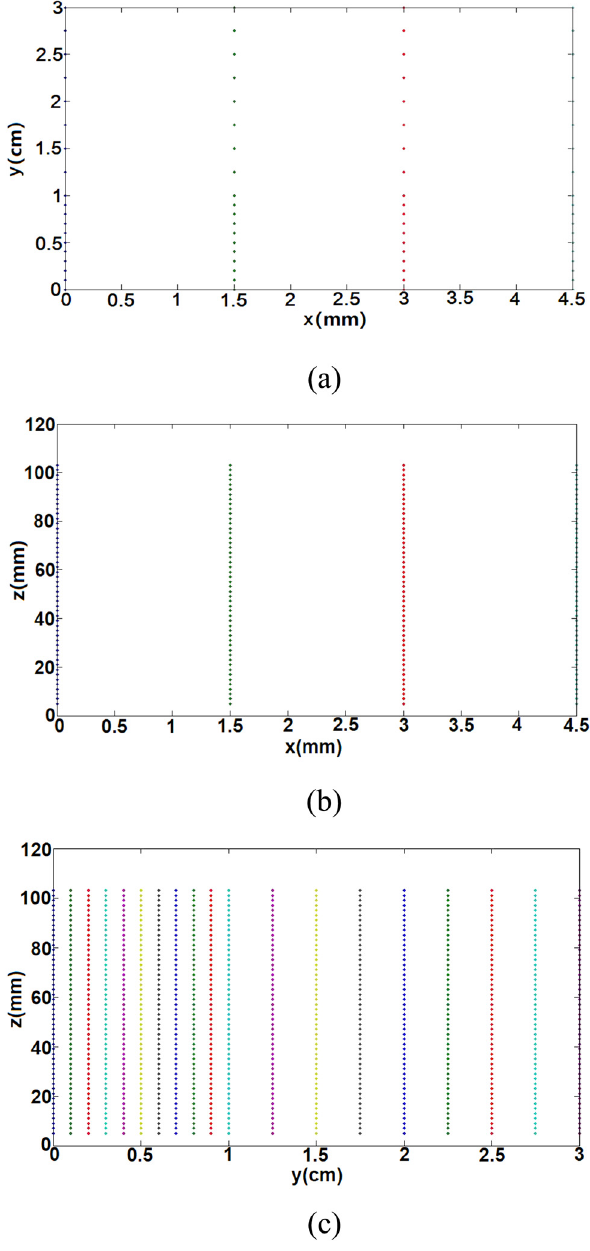
Figure 3: Distribution of measuring points: ( a ) the projection on the xy plane; ( b ) the projection on the xz plane; ( c ) the projection on the yz